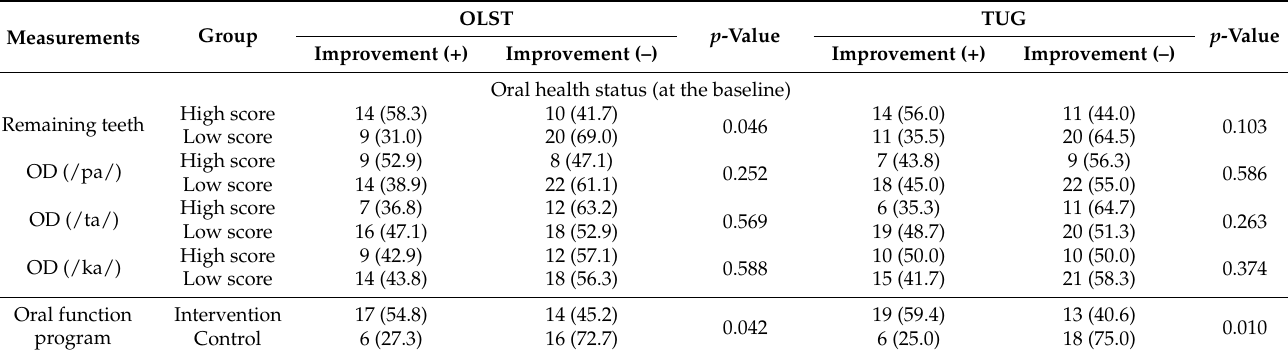
Table 4. Improvements in physical fitness seen in each oral function group, n